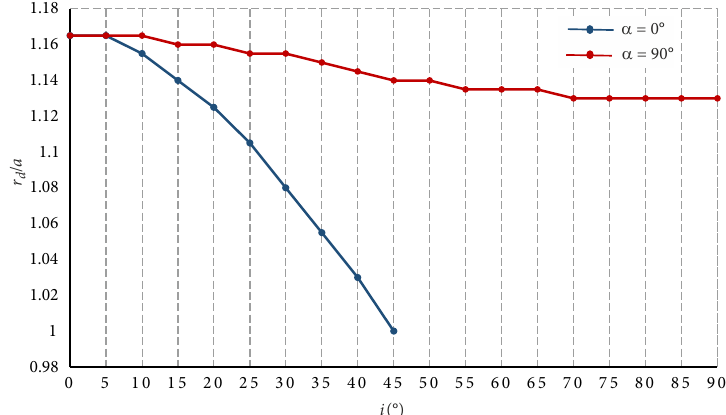
Figure 13. Normalized failure depth versus orientation angle for the reverse faulting stress